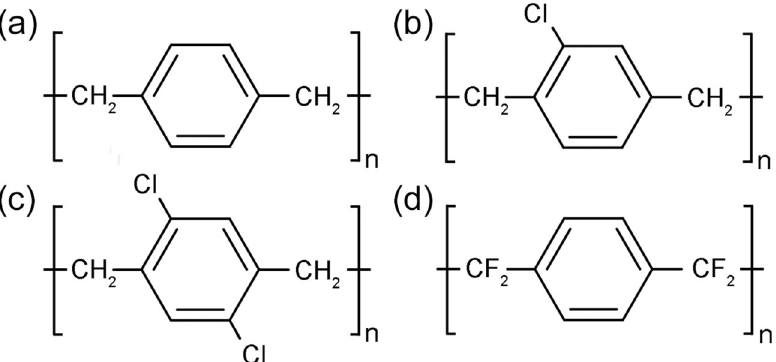
Fig 1. Chemical structure of the parylene derivatives. (a) Parylene-N, (b) Parylene-C, (c) Parylene-D and (d) Parylene-HT.